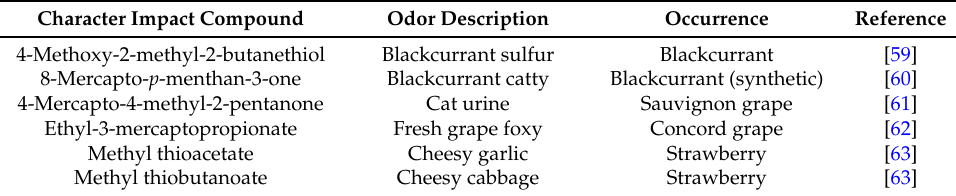
Table 2. Character-impact sulfur compounds in red